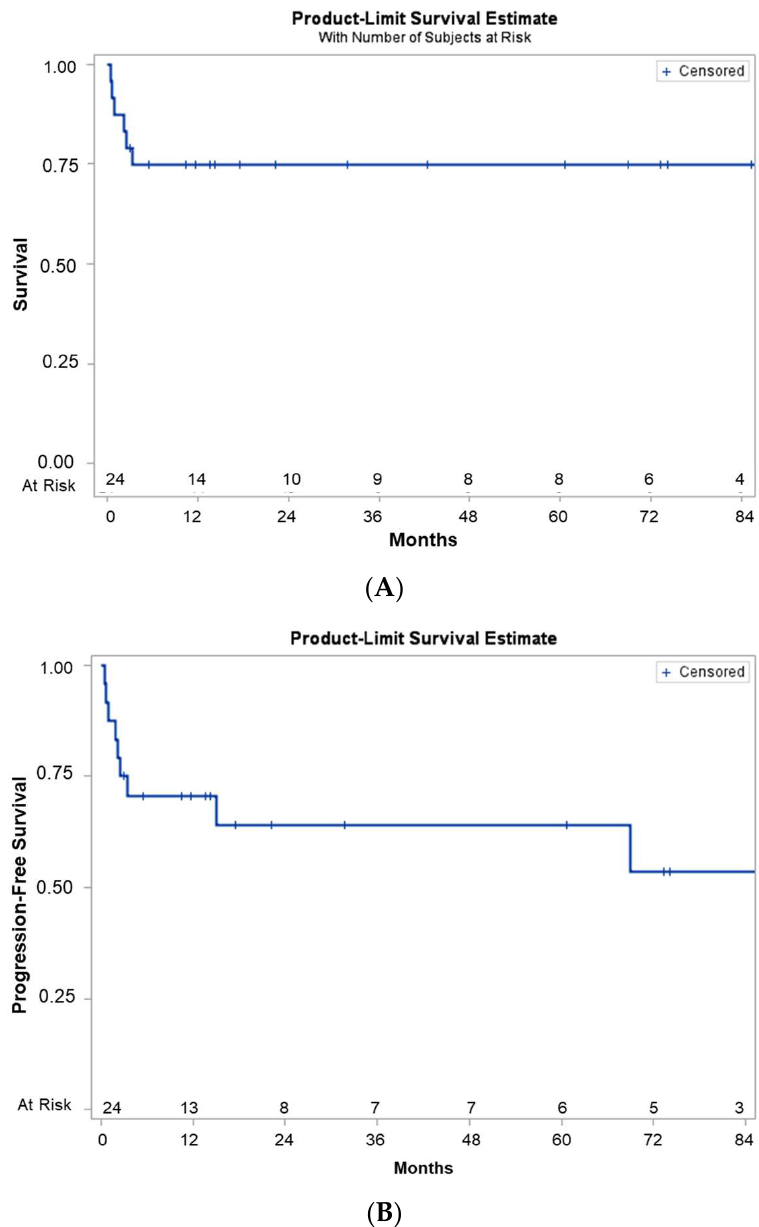
Figure 1. The OS rate ( A ) and the PFS rate ( B ).